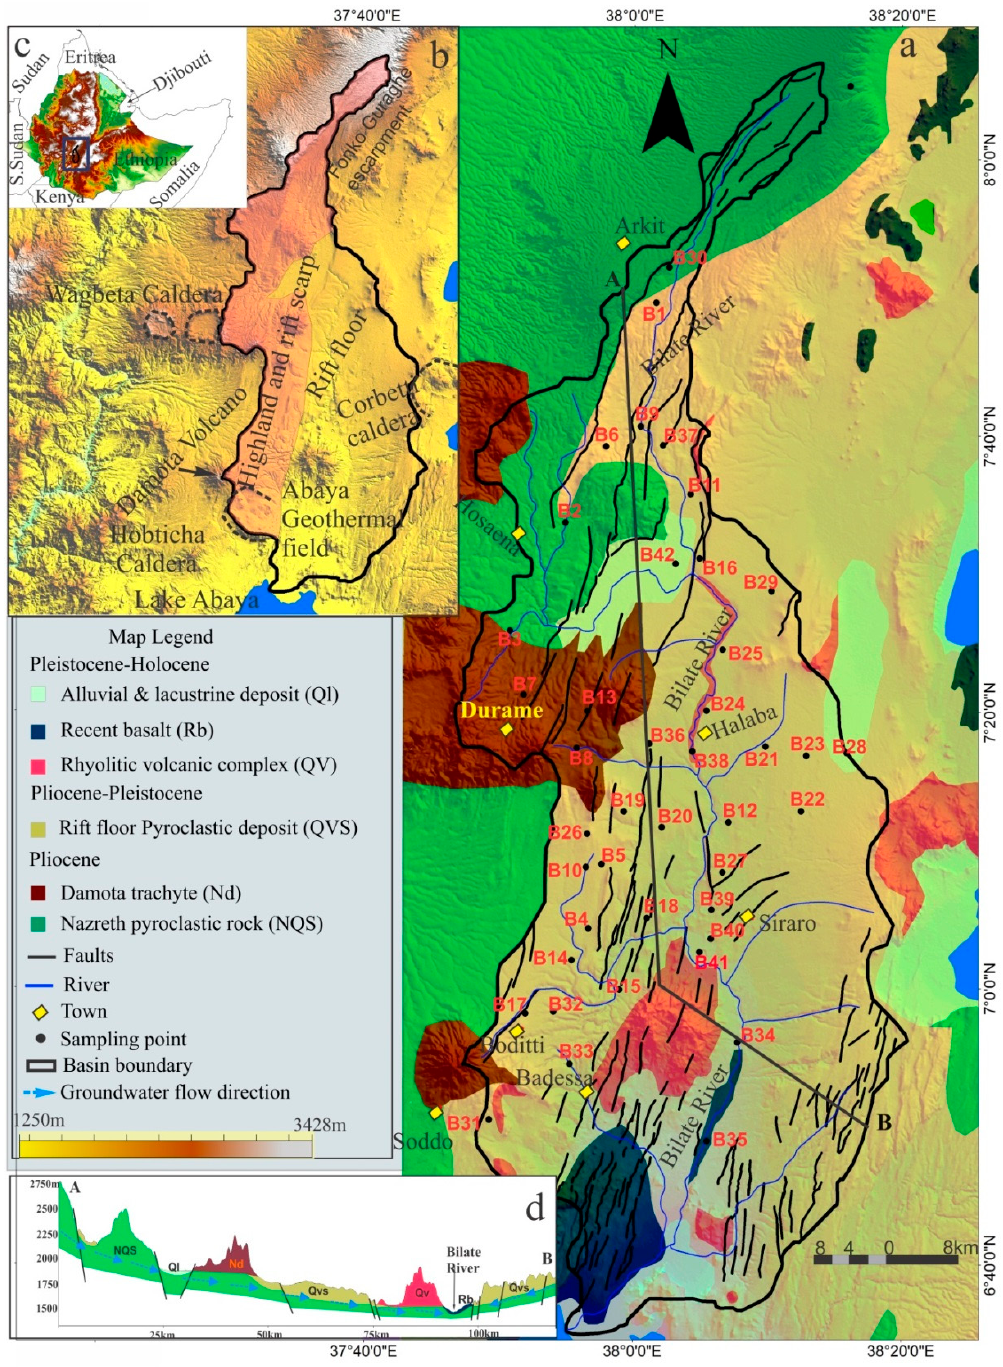
Figure 1. Simplified geological map of the Bilate river basin with sampling sites ( a ), modified from [28,30]. Inset map shows topography ( b ), location of the study area, ( c ) cross section showing the lithologic variation for A–B( d ). Note; the light shaded area in figure ( b ) shows the highland and escarpment. B1–B42 in figure ( a ) referred to sample code (see Supplementary